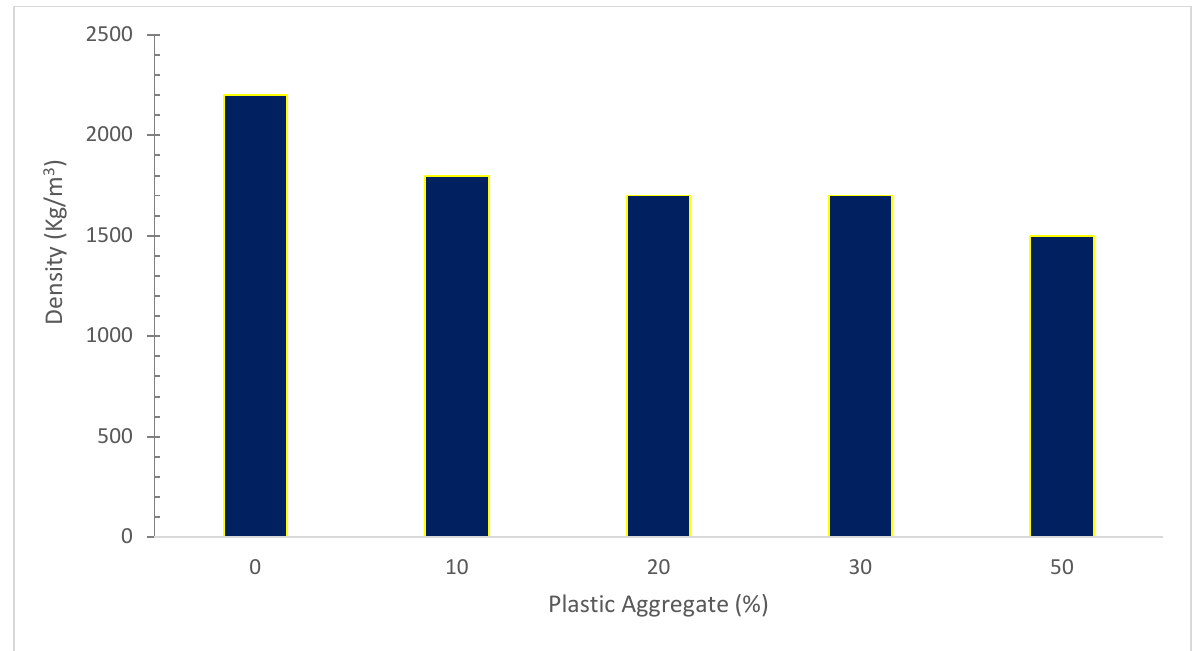
Figure 12. Density: Data Source [22].